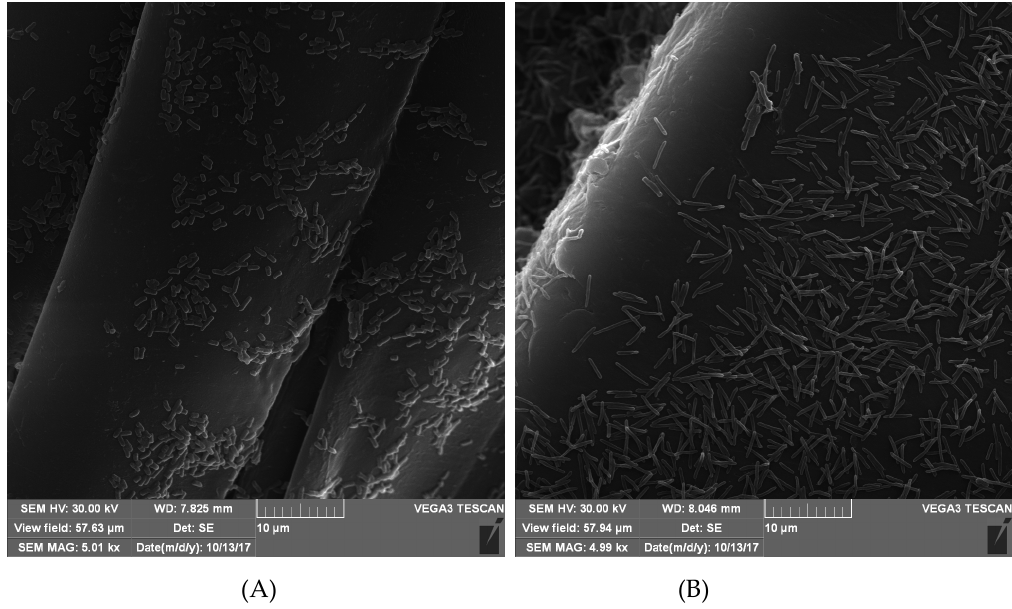
Figure 4. SEM photomicrographs of the Codubix prosthesis surface ( A ) modified with α 1 -AT and ( B ) unmodified, after incubation with Candida albicans cells.